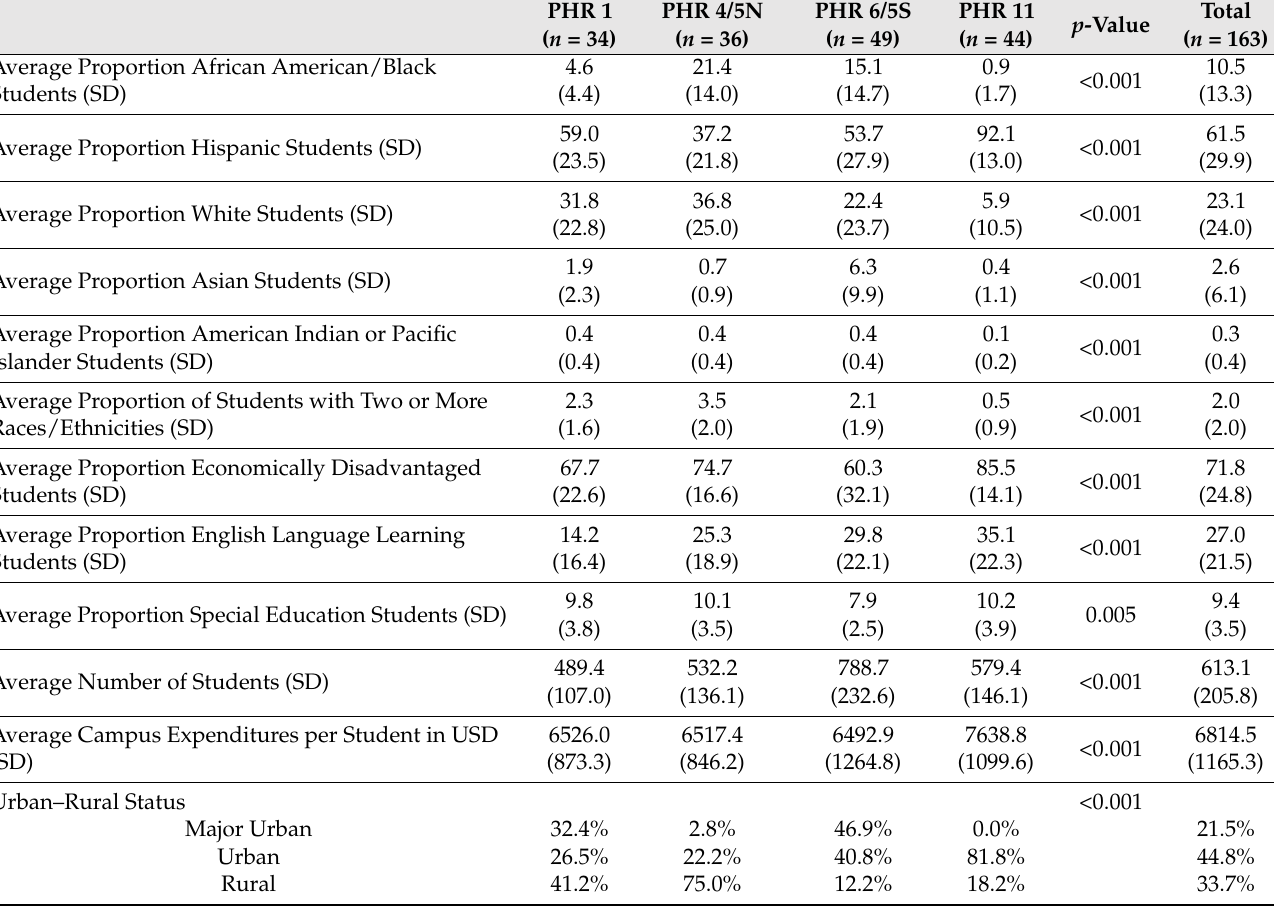
Table 2. Characteristics of Schools with Campus Improvement Plans in Texas (SPAN 2015–2016 and